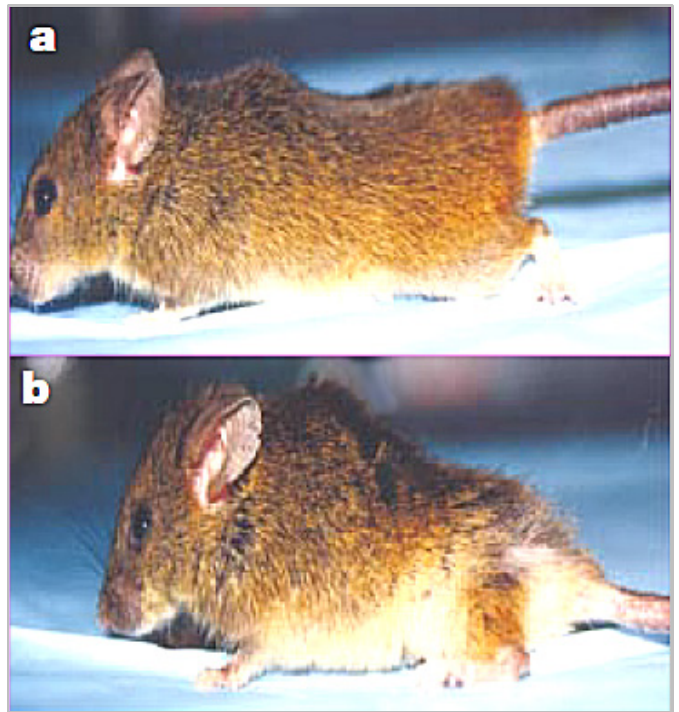
Figure 2. Wild-type mouse ( a ) compared to (b), smaller-sized p53 mutant mouse with kyphosis.